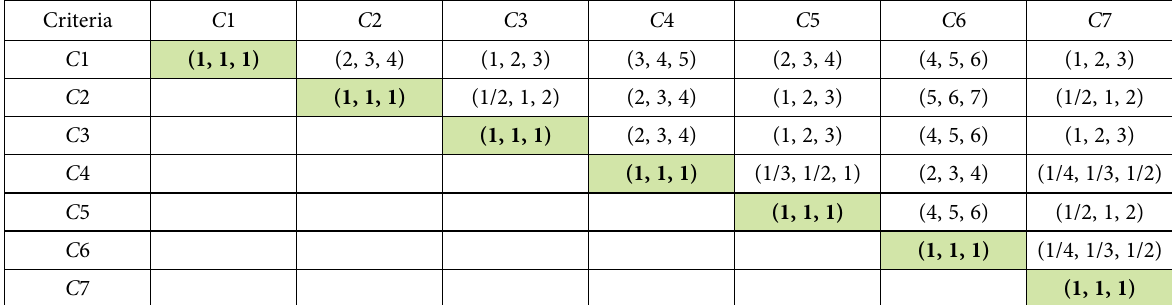
Table 4. Pairwise comparisons using fuzzy triangular numbers Criteria